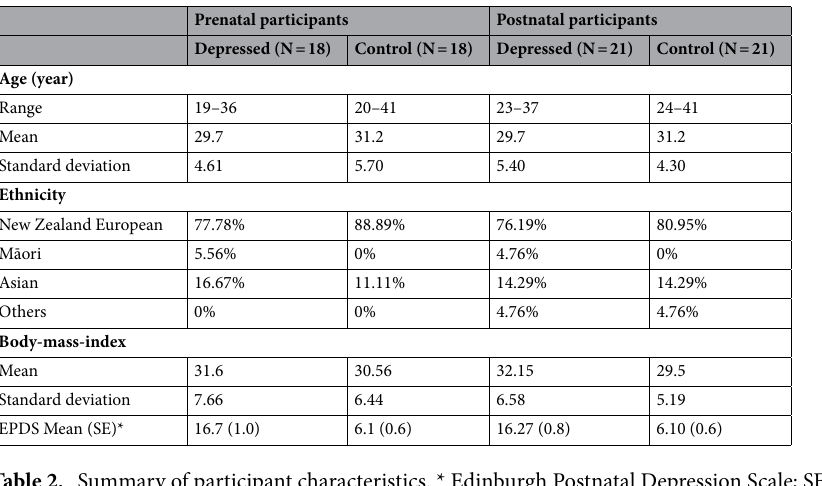
Table 2. Summary of participant characteristics. * Edinburgh Postnatal Depression Scale; SE-standard error.